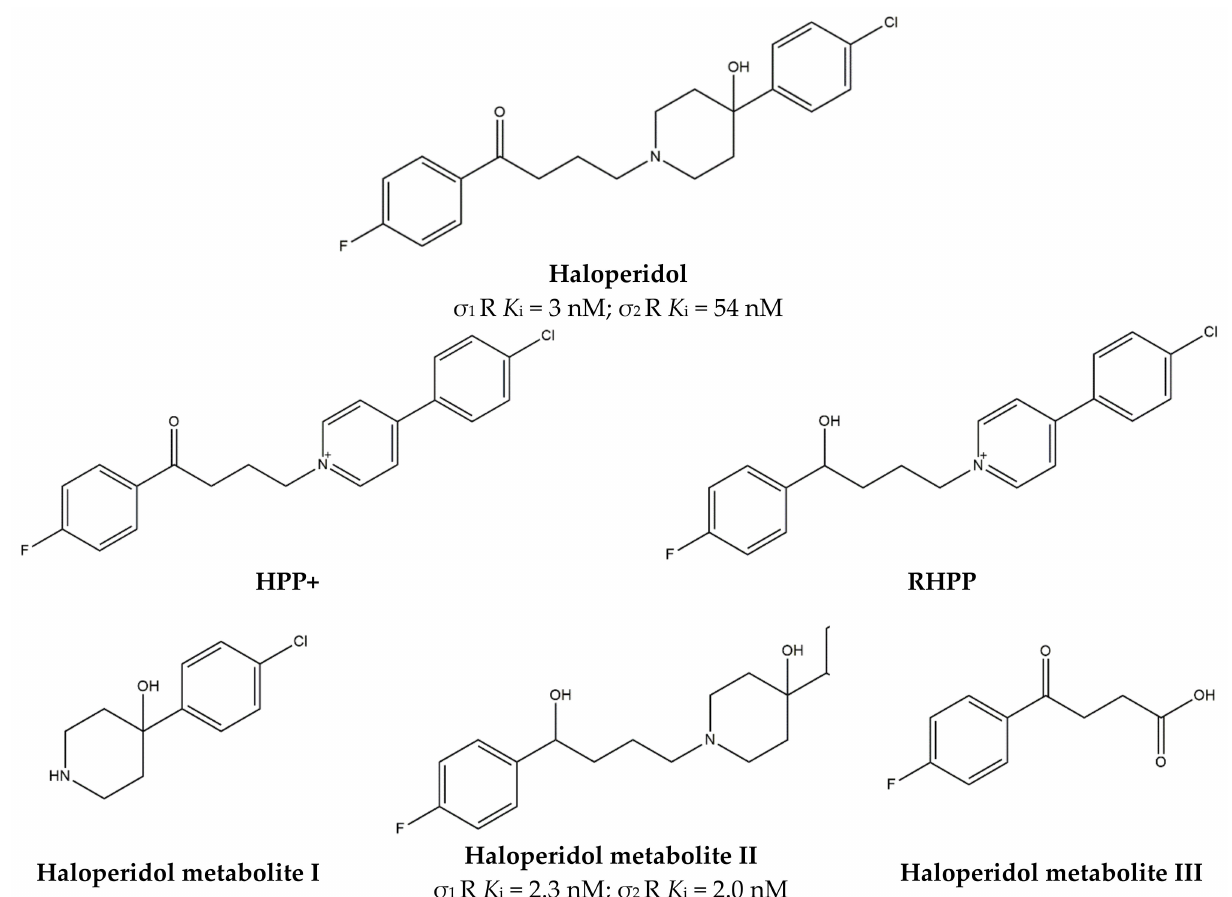
Figure 12. Haloperidol and its metabolites with K i values for σ 1 and σ 2 receptors ( σ 1 R and σ 2 R) [127–129]. After administration, Haloperidol undergoes a complex metabolism that leads to toxic metabolites such as 4-(4-chlorophenyl)-1-[4-(4-fluorophenyl)-4-oxybutyl]pyridinium ion (HPP+) and 4-(4-(chlorophenyl)-1–4-(fluorophenyl)-4-hydroxybutyl-pyridinium (RHPP+) (Figure 12). In addition, also non-toxic metabolites have been observed (HP metabolites), such as HP metabolite II [130] and HP metabolites I and III [131] (Figure 12).